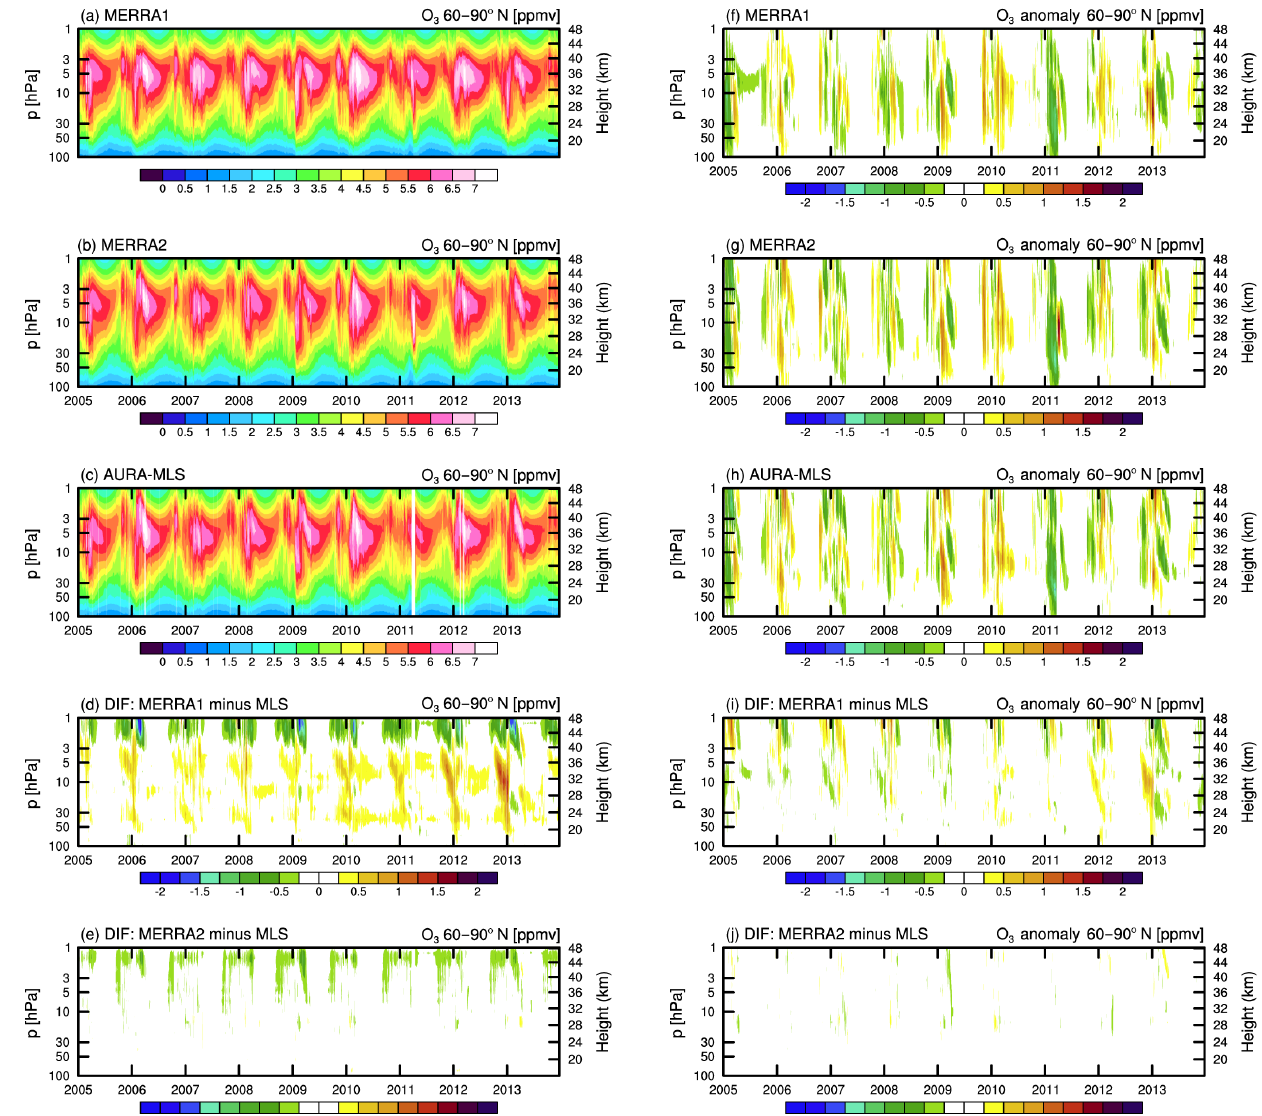
Figure A2. Time series of total ozone (left column panels) and ozone anomaly (right column panels) averaged between 60 and 90 ◦ N as a function of height and time for (a, f) MERRA-1, (b, g) MERRA2, and (c, h) AURA MLS datasets from 2005 to 2013. Also plotted, the total ozone and ozone anomaly differences between MERRA-1 and AURA MLS ( d and i , respectively) and the differences between MERRA2 and AURA MLS ( e and i ,